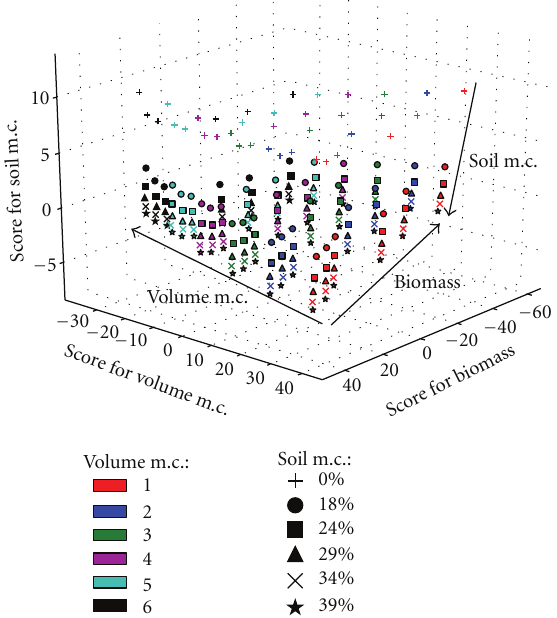
Figure 16: Result of a Canonical Analysis performed on biomass, with radar HH, HV, VV radiometry and optical NDVI, GVMI, and NINSOL